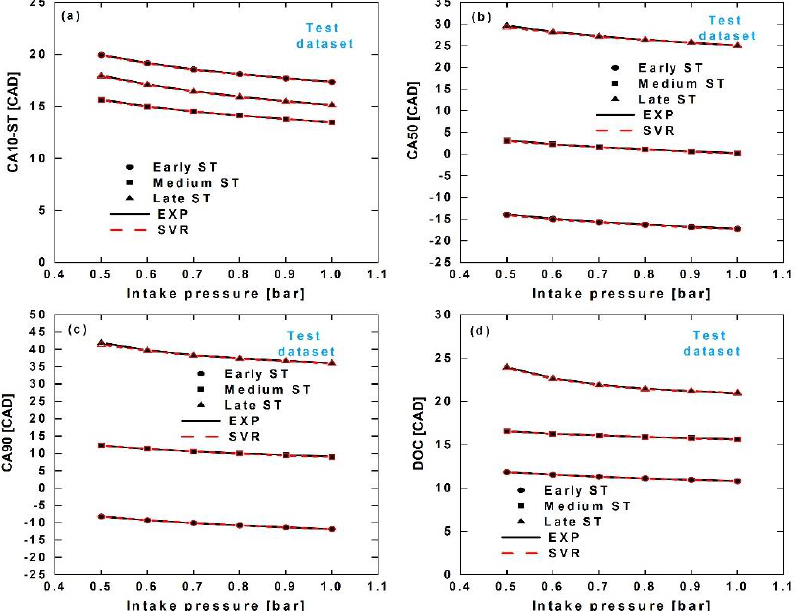
Figure 13. Effect of engine load on the combustion phasing, at constant engine speed (2600 RPM). ( a ) CA10 − ST; ( b ) CA50; ( c ) CA90; and ( d ) DOC.